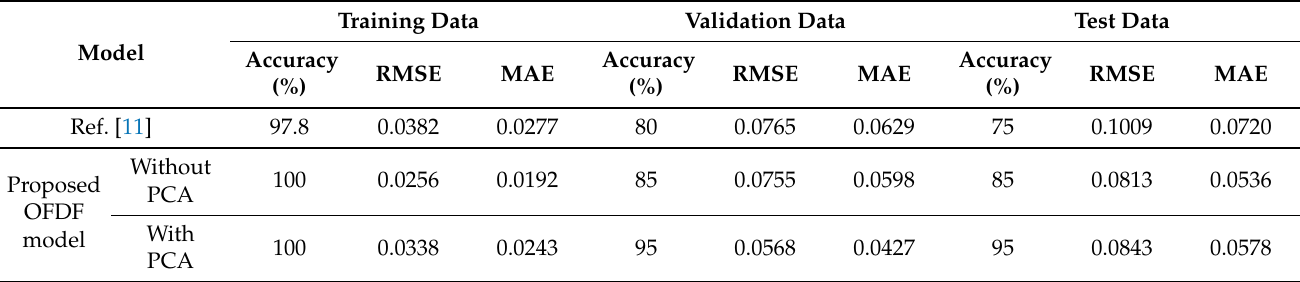
Table 5. Performance comparison between the existing OFDF model [11], the proposed OFDF model without PCA, and the proposed OFDF model with